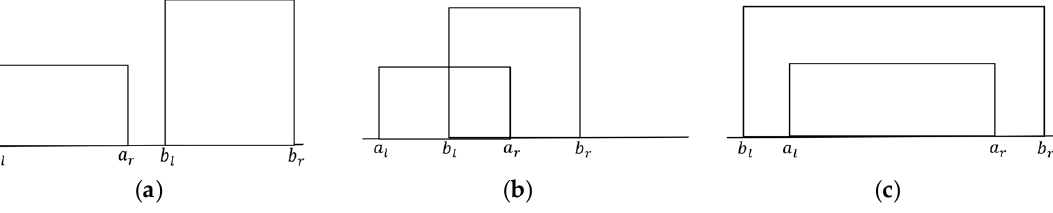
Figure 3. The example of interval relations, ( a ) is the exclusion case; ( b ) is the overlapping case and ( c ) is the inclusion case.